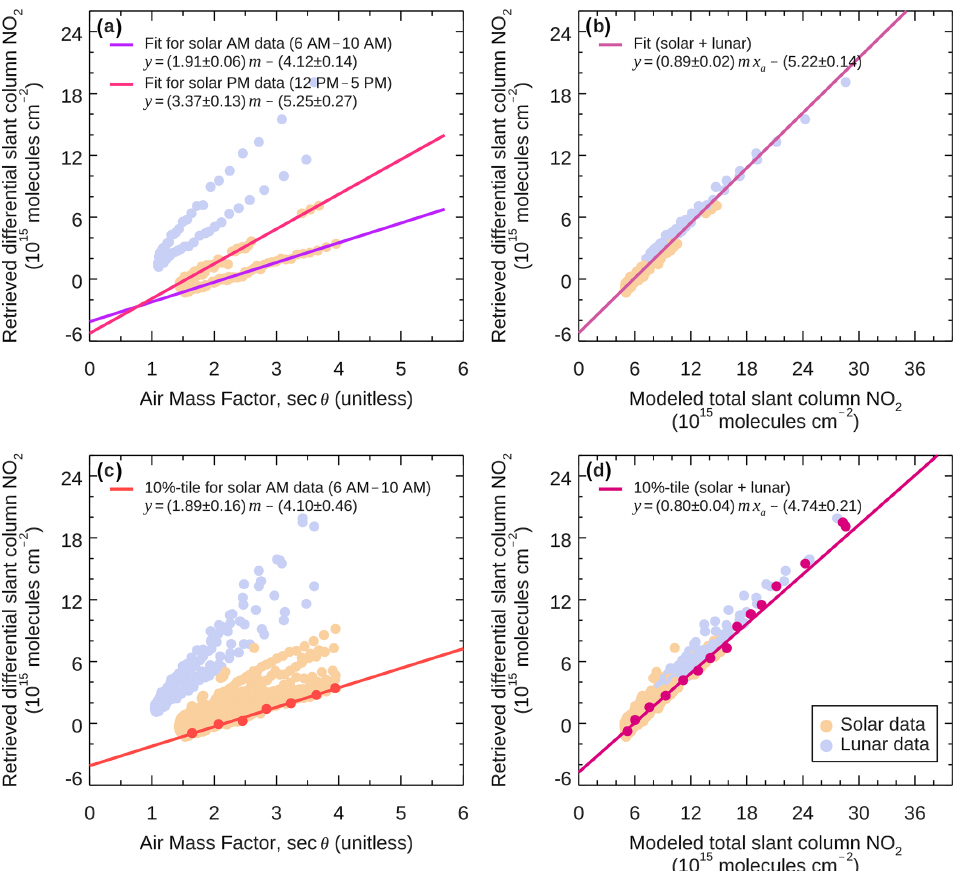
Figure A1. Comparison of the standard MLE (a, c) and the modified MLE (MMLE) (b, d) introduced in this work for single-day (a, b) and multiple-day data (c, d) . Panel (d) is the same as Fig. 3 except for the separation of the daytime and nighttime data.